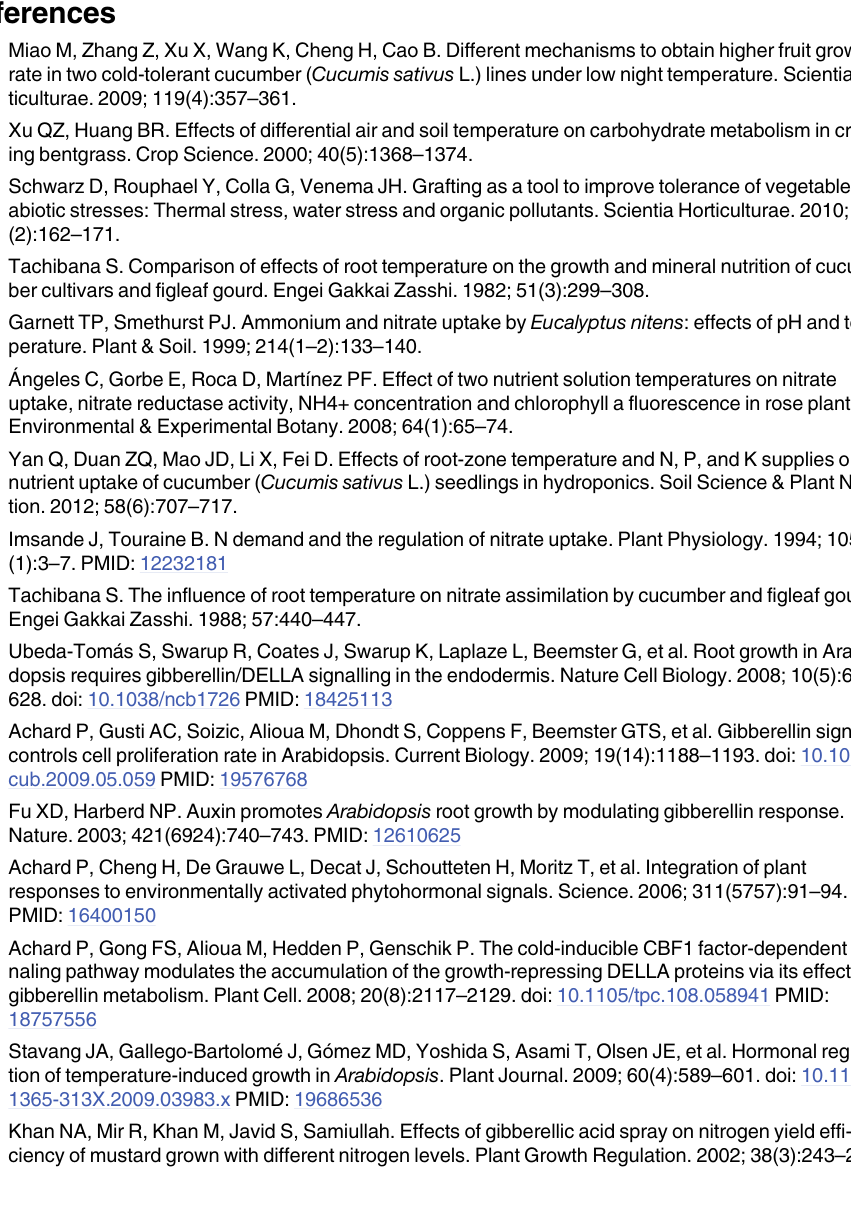
S1 Table. The list of gene specific primes for qPCR.